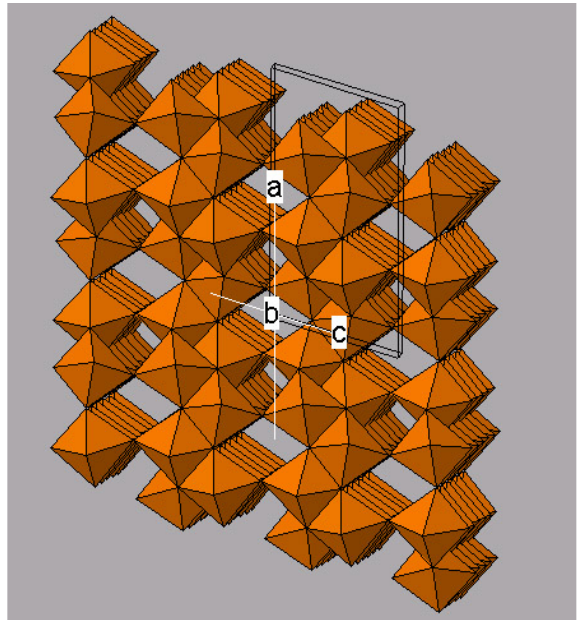
Fig. 1 Crystal structure of TiO 2 (B): a=12.163˚ A, b=3.735 ˚ A, c=6.513 ˚ A, and β =107.29 ◦ , (Z=8)